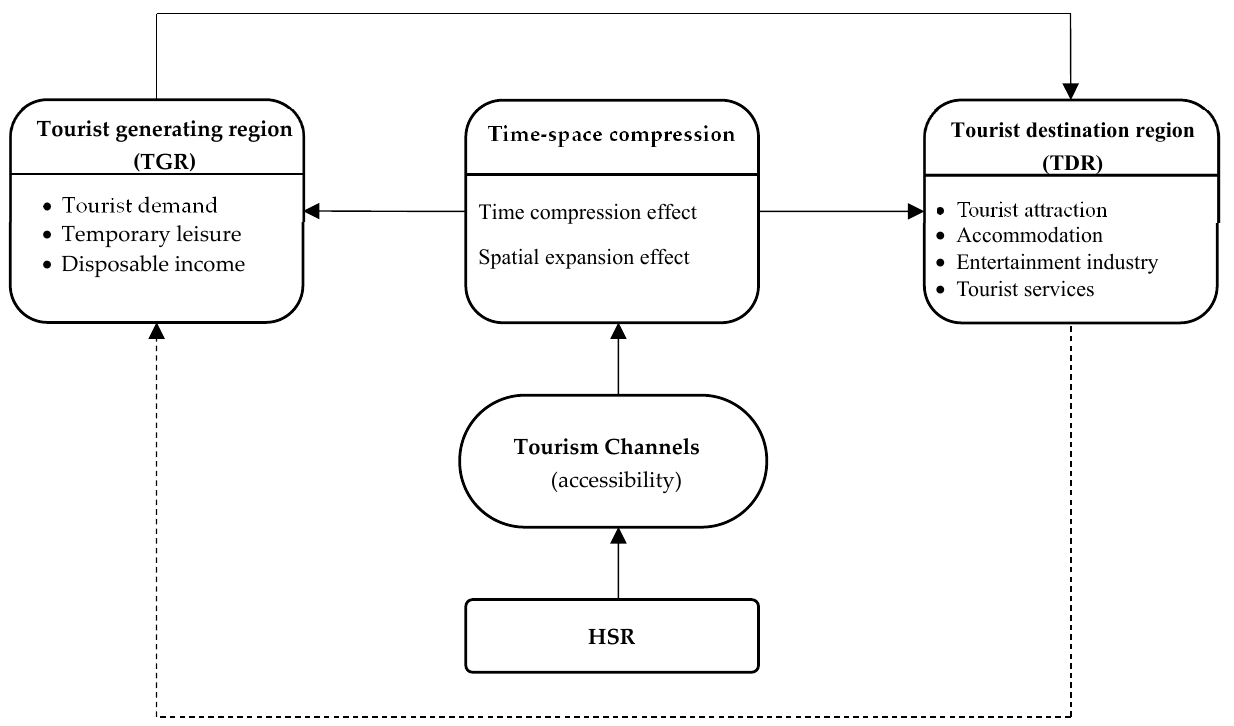
Figure 1. Time-space compression model in tourism context.